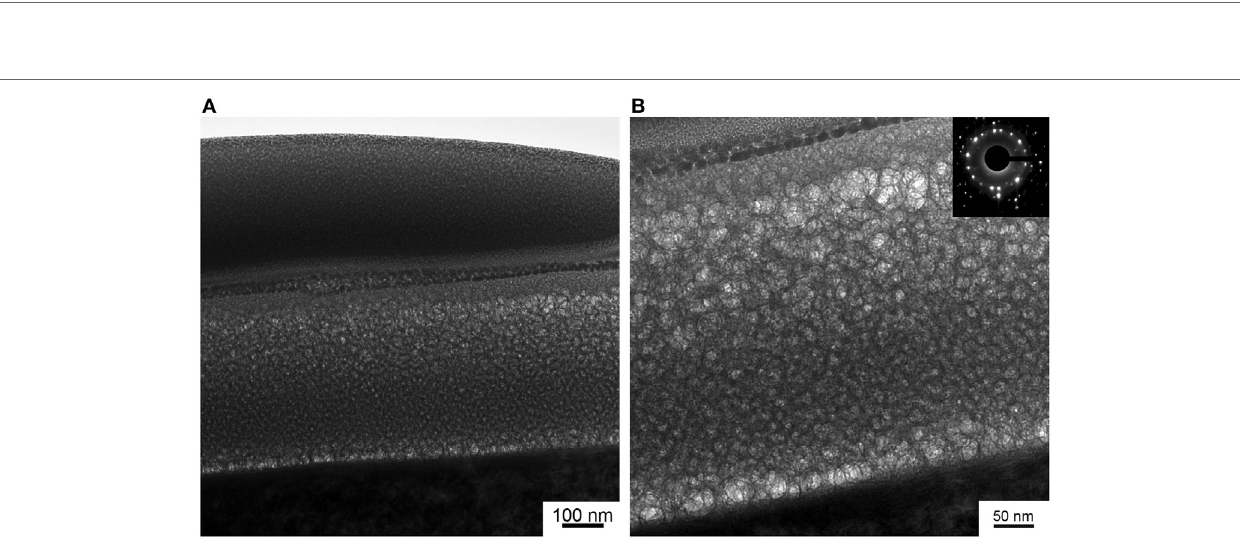
FigUre 2 | Thin lamella of the Zn substituted HA coating deposited on ultrafine-grained Ti (a) , cross-section SEM shows a set of protective and conductive layers on the deposited film with an estimated HA-Zn coating thickness (B)